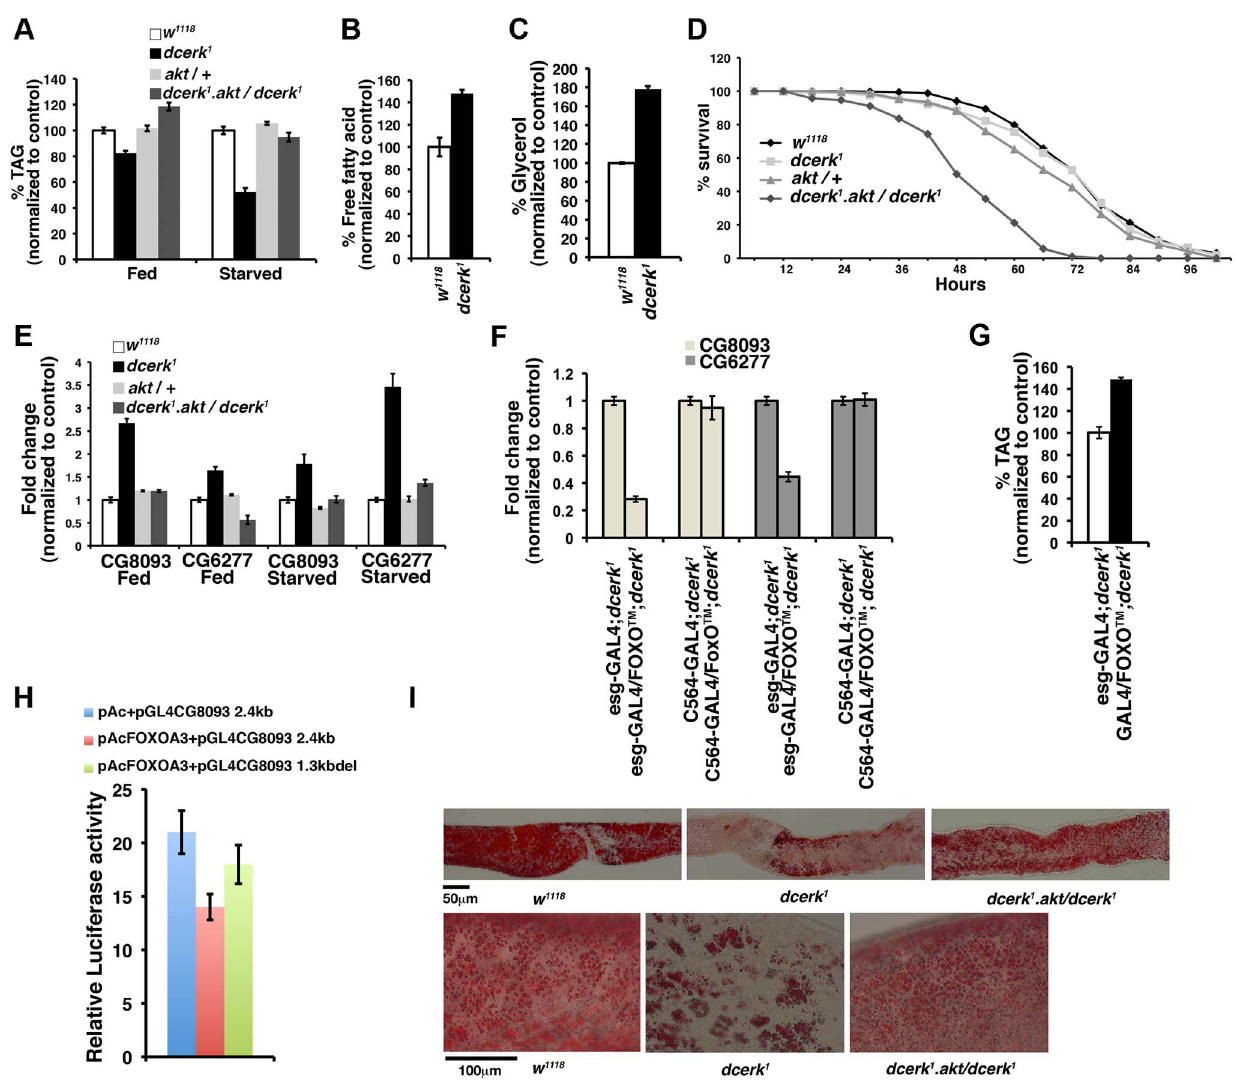
Figure 4. CG8093 and CG6277 are novel lipases in the gut activated by AKT/FOXO in dcerk 1 . (A). Relative TAG level in ad libitum fed dcerk 1 is 80% of w 1118 and increases to 120% when AKT is reduced. Relative TAG level in 20 hr starved dcerk 1 is 50% of w 1118 and significantly increases when AKT is reduced. n=3, error bars represent standard deviation. (B). Free fatty acids were measured in lysates prepared from starved w 1118 and dcerk 1 flies. Mutants show increased free fatty acids compared to w 1118 . (C). Glycerol was measured in lysates prepared from starved w 1118 and dcerk 1 flies. Mutant shows increased glycerol compared to w 1118 . (D). w 1118 , dcerk 1 , akt / + and dcerk 1 .akt/dcerk 1 flies are subjected to starvation and the number of surviving flies is recorded at 6 hr intervals. 200 flies divided into 10 groups for each genotype are used in one experiment. Three independent experiments are performed and the average percentage survival relative to w 1118 is shown for each time interval. Reduction in AKT increases the starvation sensitivity of dcerk 1 flies. (E). QPCR analysis shows transcript levels of two lipases CG8093 and CG6277 (identified by microarray analysis) are increased in dcerk 1 relative to w 1118 both in the fed and 20 h starved state. Both transcript levels are decreased upon reduction of AKT in dcerk 1 . n=3, error bars represent standard deviation. (F). Overexpression of constitutively active FOXO in the midgut decreases whole animal transcript levels of CG8093 and CG6277 while fat body specific expression does not significantly affect them in dcerk 1 . FOXO overexpression with each driver is quantified by QPCR using FOXO primers and normalized. n=3, error bars represent standard deviation. (G). Midgut specific overexpression of constitutively active FOXO increases whole animal TAG level in dcerk 1 . The TAG level in dcerk 1 expressing esg-GAL4 driver is taken as 100%. (H). Constitutive FOXO represses CG8093 in luciferase reporter assays. A 2.4 kb fragment (genomic region between 1773 bp to 4177 bp from transcription start site) containing FOXO core motifs upstream of CG8093 in a luciferase reporter vector or a 1.3 kb fragment (region between 2842 bp and 4177 bp) deficient of the FOXO motifs was cotransfected with constitutive dFOXO A3. FOXO represses transcription of the 2.4 kb fragment while the repression is less when the binding sites are deleted. (I). Dissected adult midguts stained with Oil Red O show significantly reduced lipid staining in starved dcerk 1 compared to w 1118 . dcerk 1 mutants with reduced AKT show comparatively more Oil Red O staining in the midgut. 15–20 guts are examined for each genotype in one experiment, which is carried out three times. Scale bar represents 50 m m. Magnified view of dissected adult midguts from w 1118 and dcerk 1 .akt/dcerk 1 show many Oil Red O stained puncta while they are significantly reduced in dcerk 1 . Scale bar represents 50 m m.